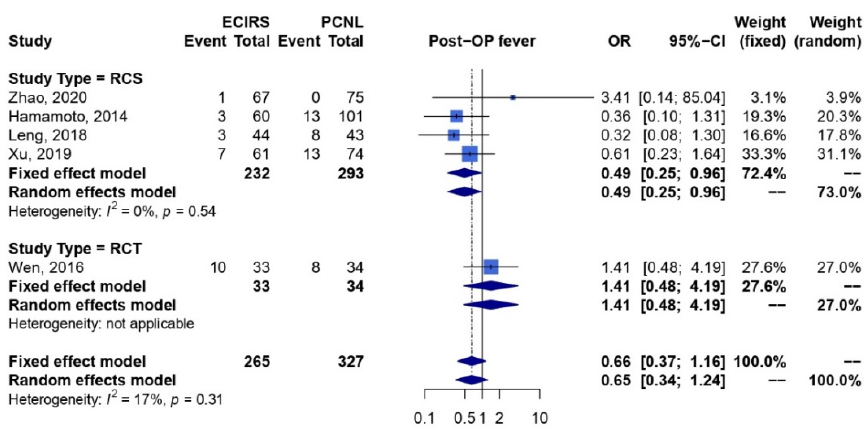
Figure A14. Subgroup analysis of outcome regarding post-operative fever. (RCS: [18–23]; RCT: